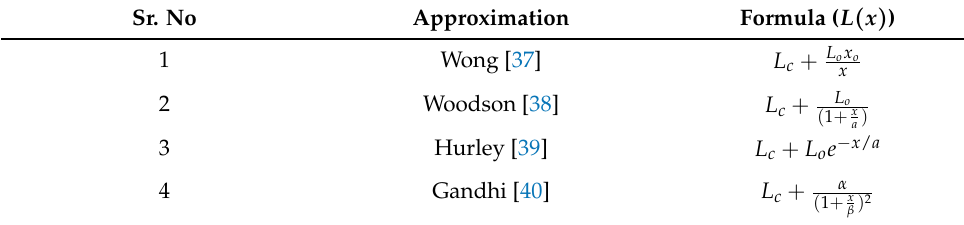
Table 2. Approximations for coil